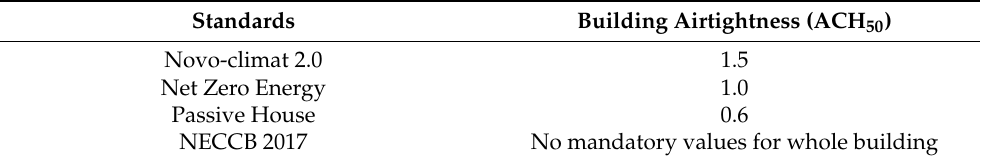
Table 5. Building airtightness targets in Codes and Standards across Canada